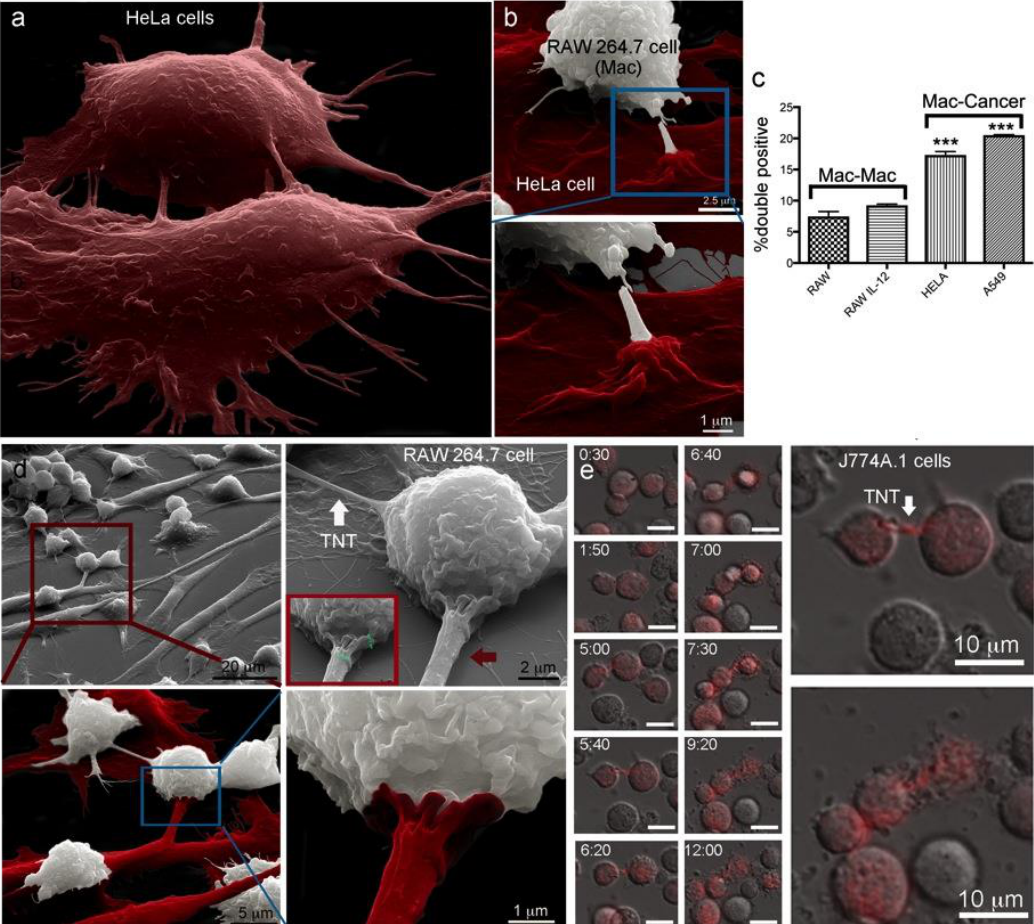
Figure 5. Heterotypic MSN transfer between murine macrophages and human HeLa cancer cells. ( a ) The pseudo-colored scanning electron microscopy (SEM) image shows HeLa cells (red) communicating via tunneling nanotubes (TNTs). ( b – d ) SEM and flow cytometry were used to visualize heterotypic TNTs and compare rates of material transfer from RAW 264.7 macrophages to other macrophages or HeLa cells. ( b ) HeLa cells (red) formed elaborate connections with murine macrophages (white) following 24 h co-culture. ( c ) Flow cytometry analysis of relative intercellular transfer of fluorescent MSN among cells initially with single color MSN and the impact of stimulation with IL−12 on transfer among macrophages. ( d ) SEM images showing homotypic connections between macrophages (white arrow) or heterotypic connections between macrophages and cancer cells (red arrow). Inset displays a size marker (green). ( e ) Merged DIC and fluorescent images showing the homotypic transfer of doxorubicin between J774A.1 macrophages at select time points following initiation of co-culture (bar 10 µm in all images) of naïve macrophages with macrophages pretreated with doxorubicin-loaded mesoporous silicon particles. Two of the images are enlarged to the right to highlight the doxorubicin filled TNT (top; arrow) and subsequent cell death (bottom)., *** p < 0.001. The rate of homotypic and heterotypic MSN transfer between murine macrophages and either naive macrophages or human cancer cells was studied. Discrete populations of RAW cells